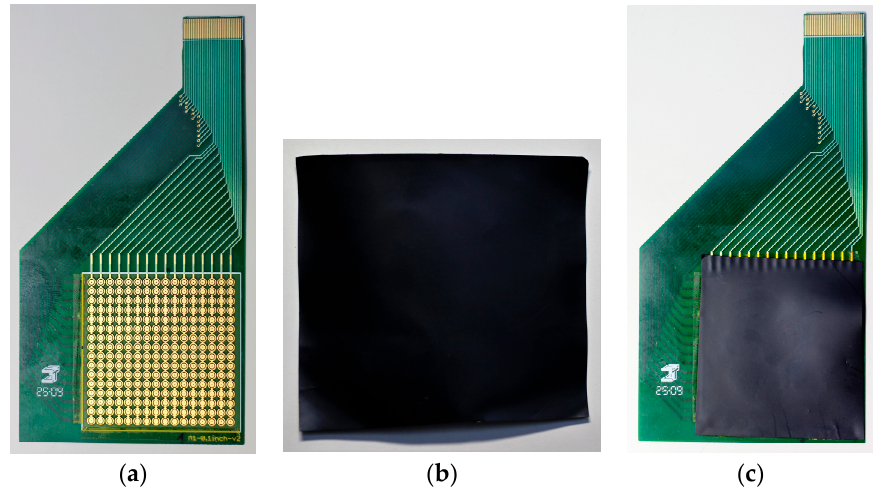
Figure 7. ( a ) Array of electrodes; ( b ) Piezoresistive sheet; ( c ) Full piezoresistive tactile sensor.